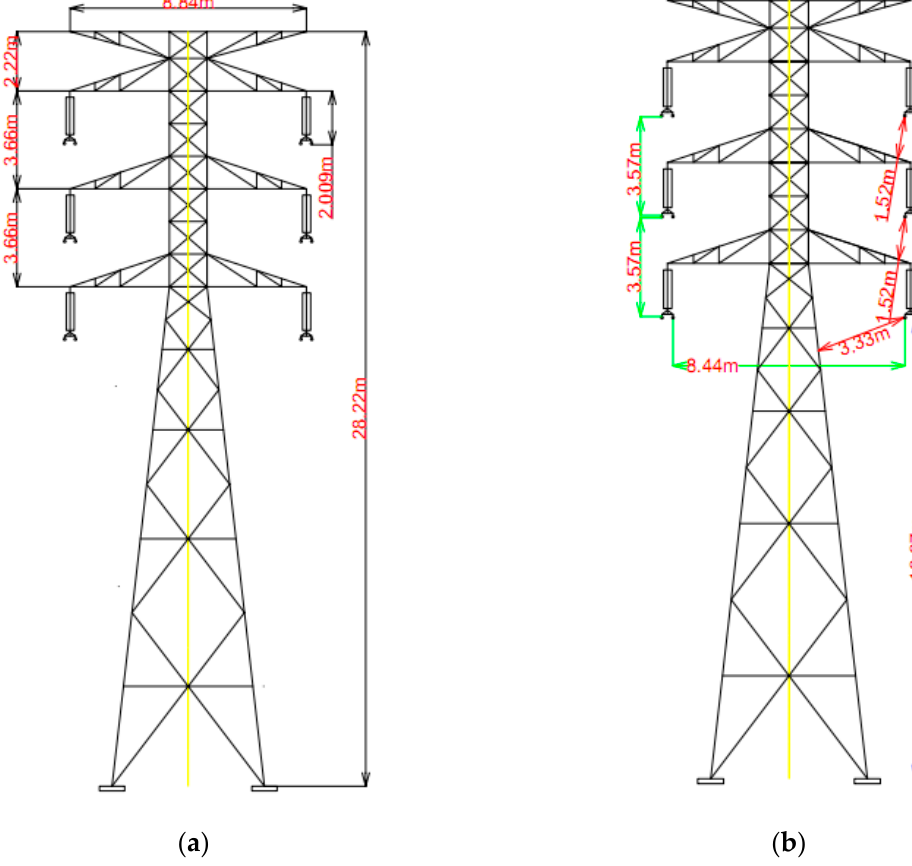
Figure 2. The typical of the 132 kV transmission tower in Malaysia; ( a ) type 23 L of tower geometry, and ( b ) available electrical clearance.